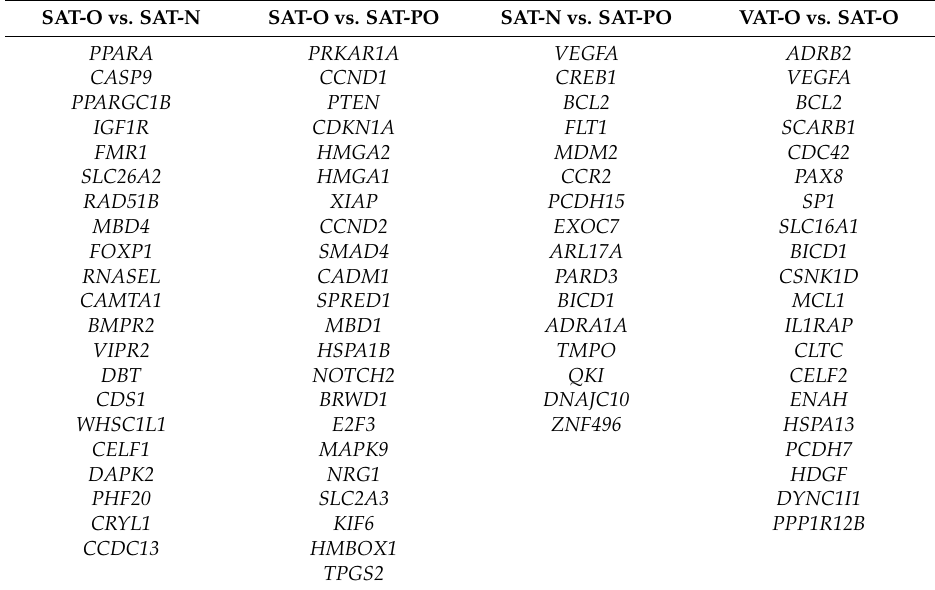
Table 3. Common obesity-related targets with the highest (>10) number of binding sites for miRNAs differentially expressed in subcutaneous (SAT) and visceral (VAT) adipose tissues of normal weight (N) and obese before (O) and after surgery (PO)